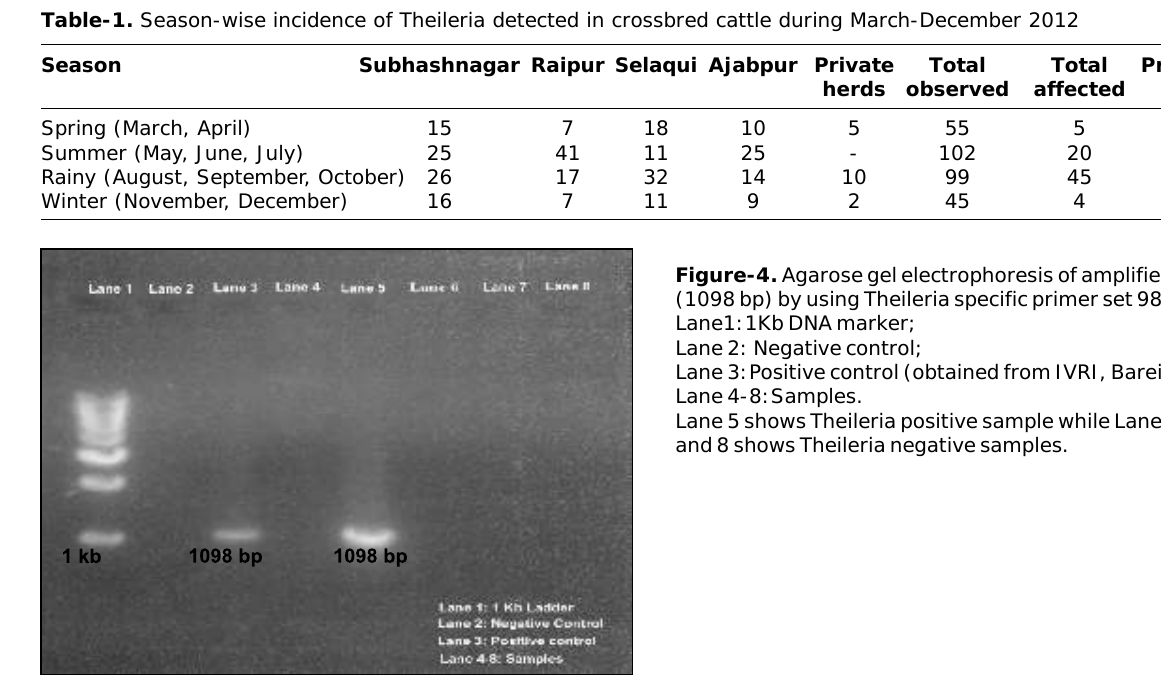
Figure-3. Graph showing the prevalence of theileriosis in different seasons- Spring (March, April), Summer (May, June, July), Rainy (August, September, October) and Winter (November, December)